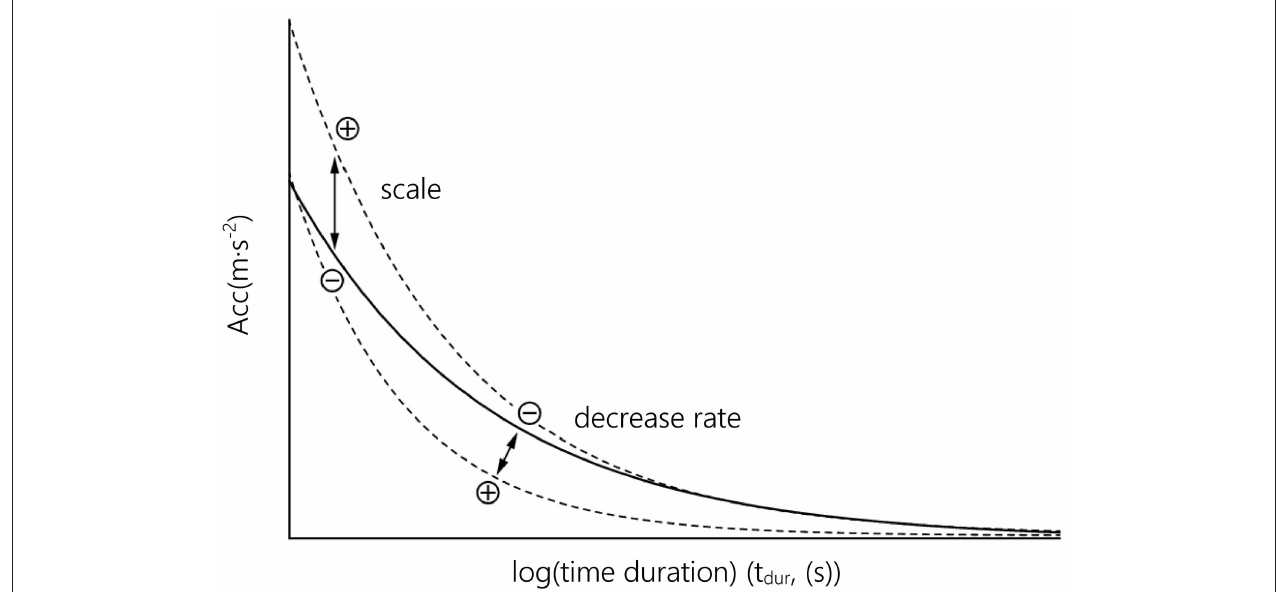
FIGURE 1 | Function parameters ( scale, decrease rate ) describing the function’s curve shape. The solid black line represents the original fitting for peak median intensities. Dashed lines show the effect of change on either scale or decrease rate .